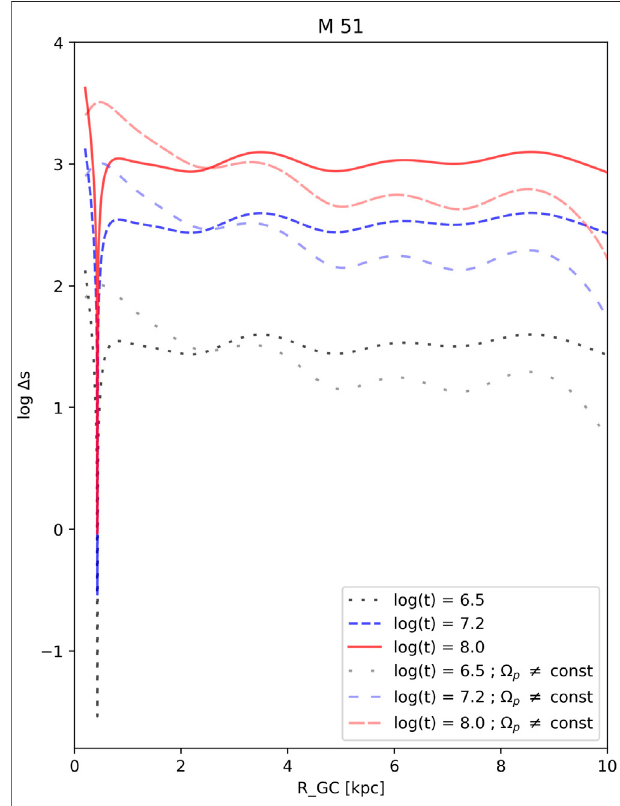
FIGURE 3 | The orbital drift of the open cluster in M 51 from their host spiralarmasafunctionofthegalacto-centricradiusandtime.Thevaluesof Δ s under the logarithm are in parsec. Used parameters: Ω p (cid:1) 50 − 90 km/s/kpc, Δ R (cid:1) 0 . 1 kpc,rotationcurvefromSofueetal.(1999),approximatedbya high-degree polynomial (deg > 15).